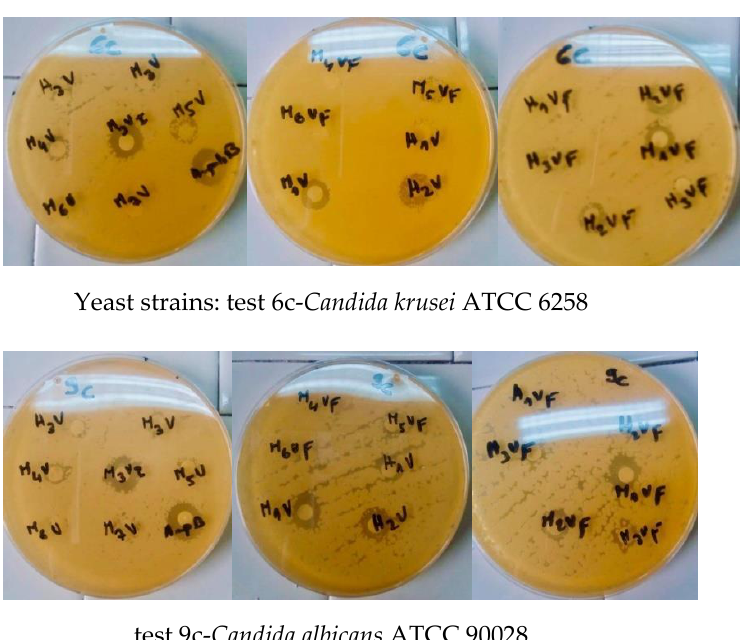
Figure 6. Antibacterial activity of some derivatives via determination of the inhibition zone (mm) around discs impregnated with 5a (M1V), 5b (M2V), 5c (M3V), 5d (M4V), 5e (M7V), 5f (H1V), 5g (H2V), 5h (H3V), 5i (M1VF), 5j (M2VF), 5k (M3VF), 5l (M4VF), 5m (M7VF), 5n (H1VF), 5o (H2VF), 5p (H3VF), and 5q (M3VI) concentration (10 mg/disk).Tetracycline (10 mg/mL) or Amphotericin B (10 mg/mL) expressed as mean ± SD (n = 3).